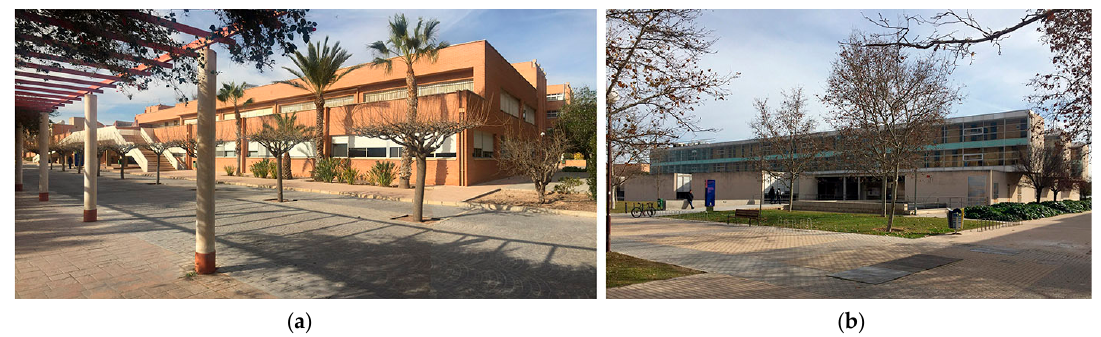
Figure 1. Faculty of Sciences (FS, 1982), Pilar Vázquez Carrasco ( a ) and Higher Polytechnic School IV (HPS, 1999), Dolores Alonso Vera ( b ), University of Alicante. Photos: Authors.